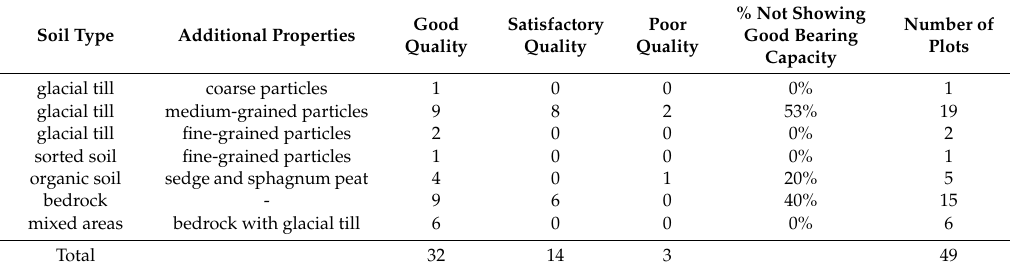
Table 2. Distribution of soils and their bearing capacity identified in Tuusniemi,